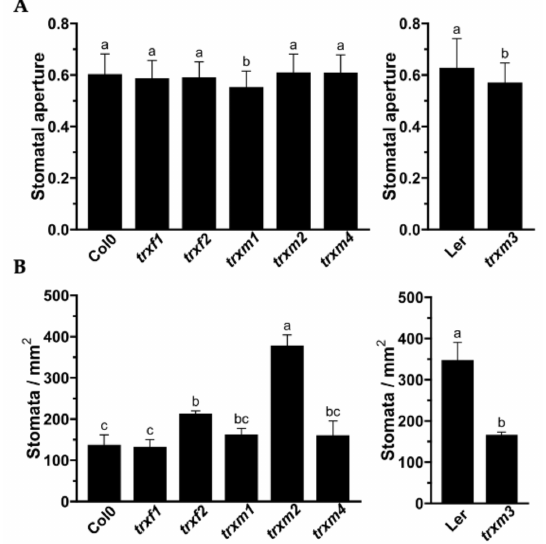
Figure 6. Stomatal characterization in WT (Col0 and Ler) and trxf and trxm mutant lines. ( A ) Stomatal aperture calculated as the width/length ratio. ( B ) Stomatal density of the adaxial leaf epidermis. Stomatal measurements were carried out with ImageJ 2.0.0. Different letters indicate a statistically significant difference ( p < 0.05) according to a one-way analysis followed by a Tukey’s post hoc test. n = 50 per